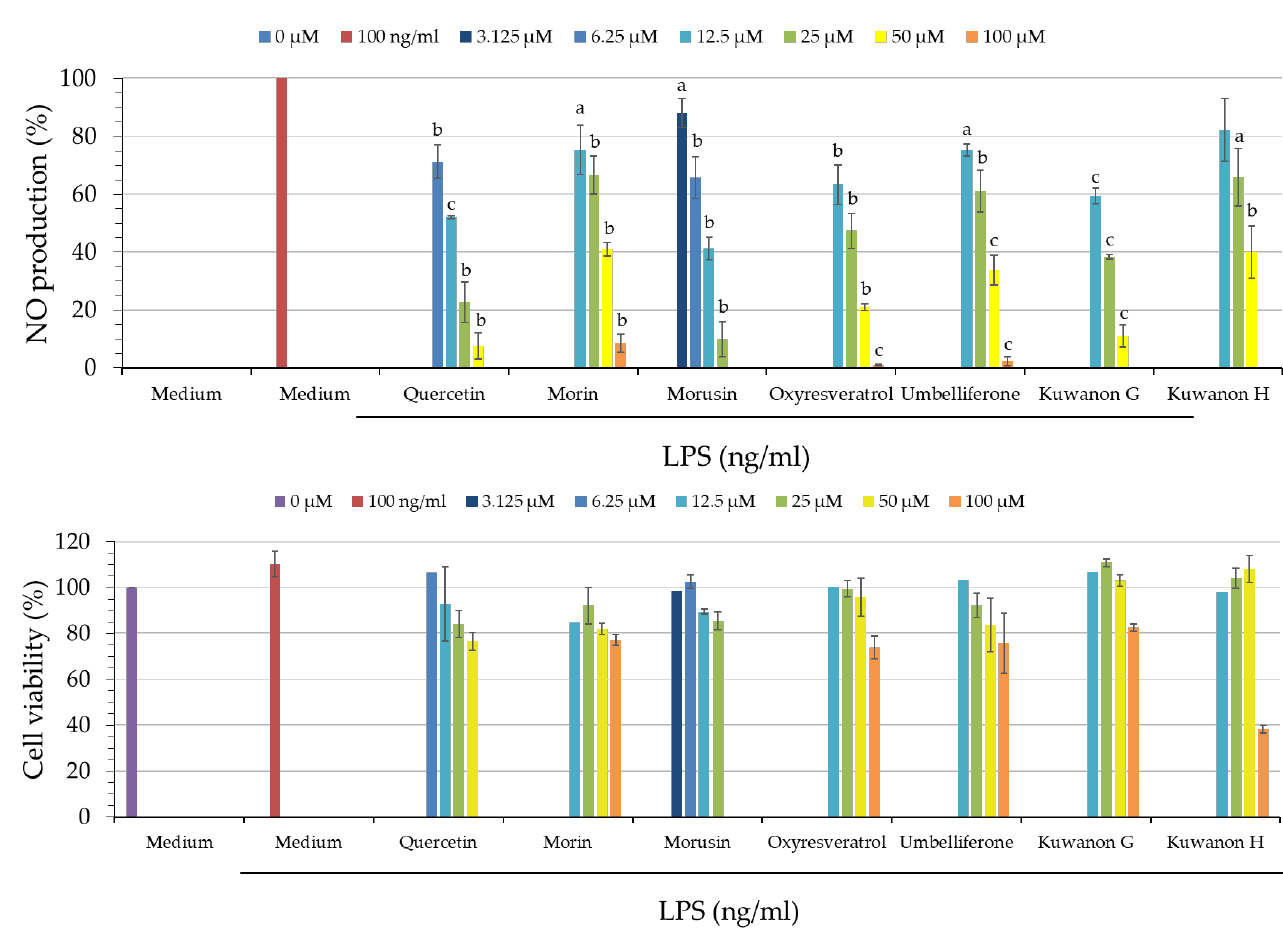
Figure 3. The effect of isolated compounds from Morus alba L. on cell viability of RAW 264.7 cells was assessed by MTT assay. Values expressed as mean ± SD ( n = 3); quercetin was used as a positive control. a p < 0.05, b p < 0.01, and c p < 0.001 compared to the LPS-induced group.